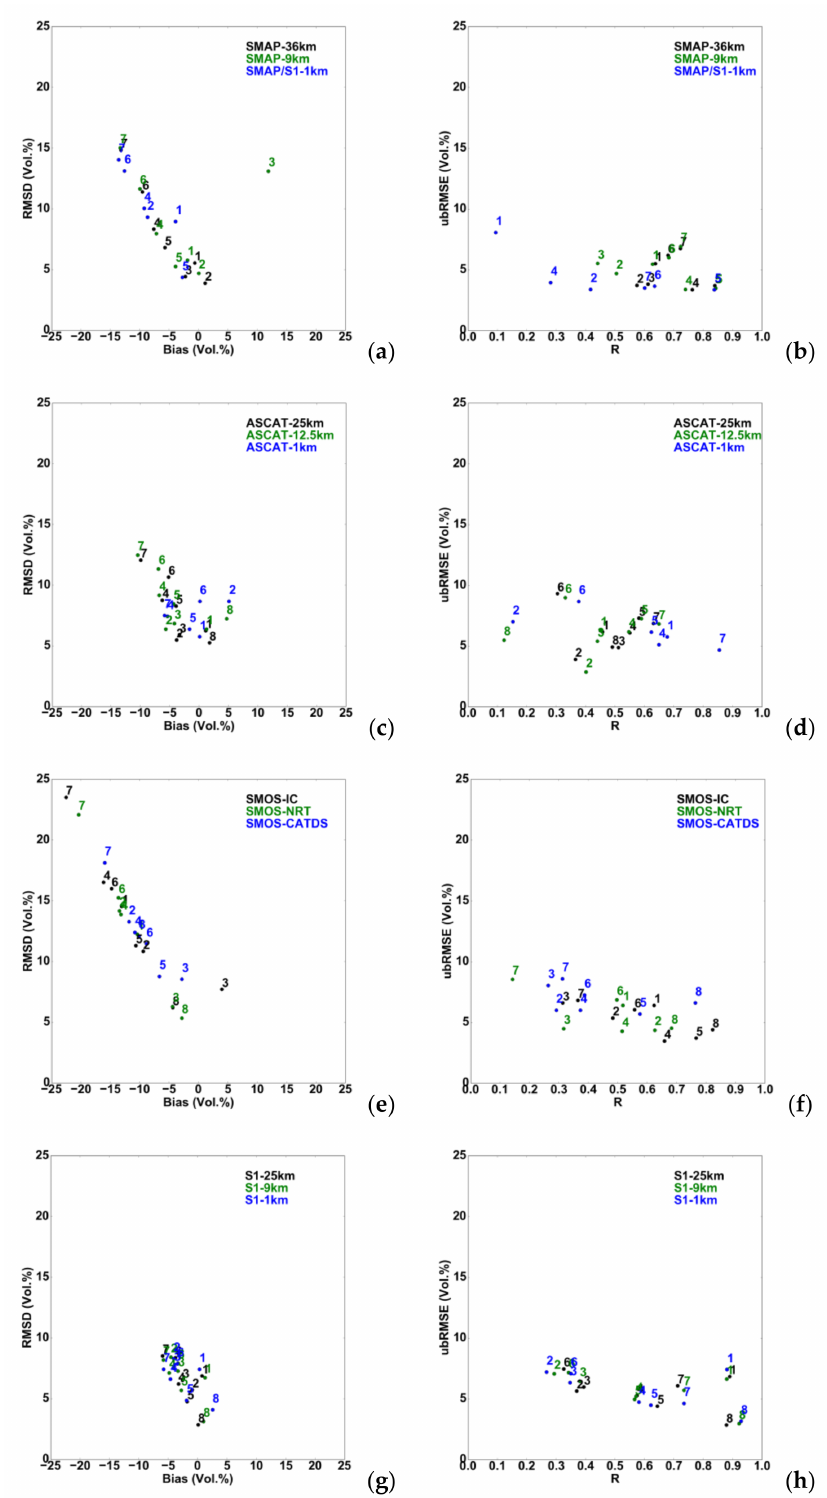
Figure 3. For each product, result of the comparison (RMSD versus Bias and ubRMSD versus R ) between soil moisture products and in situ soil moisture for each station ( a – h ). The in situ stations were represented by number from 1 to 8. 1: CRD (Creon d’Armagnac), 2: MTM (Mouthoumet), 3: NBN (Narbonne), 4: PRG (Peyrusse), 5: SFL (Saint-F é lix-Lauragais), 6: SVN (Saven è s), 7: URG (Urgons), 8: MTP